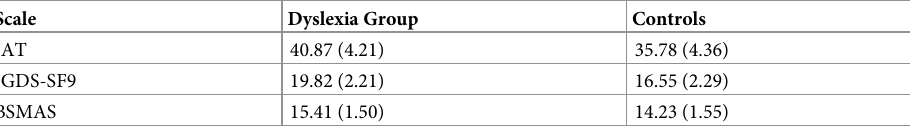
Table 2. Adjusted means and standard deviations of